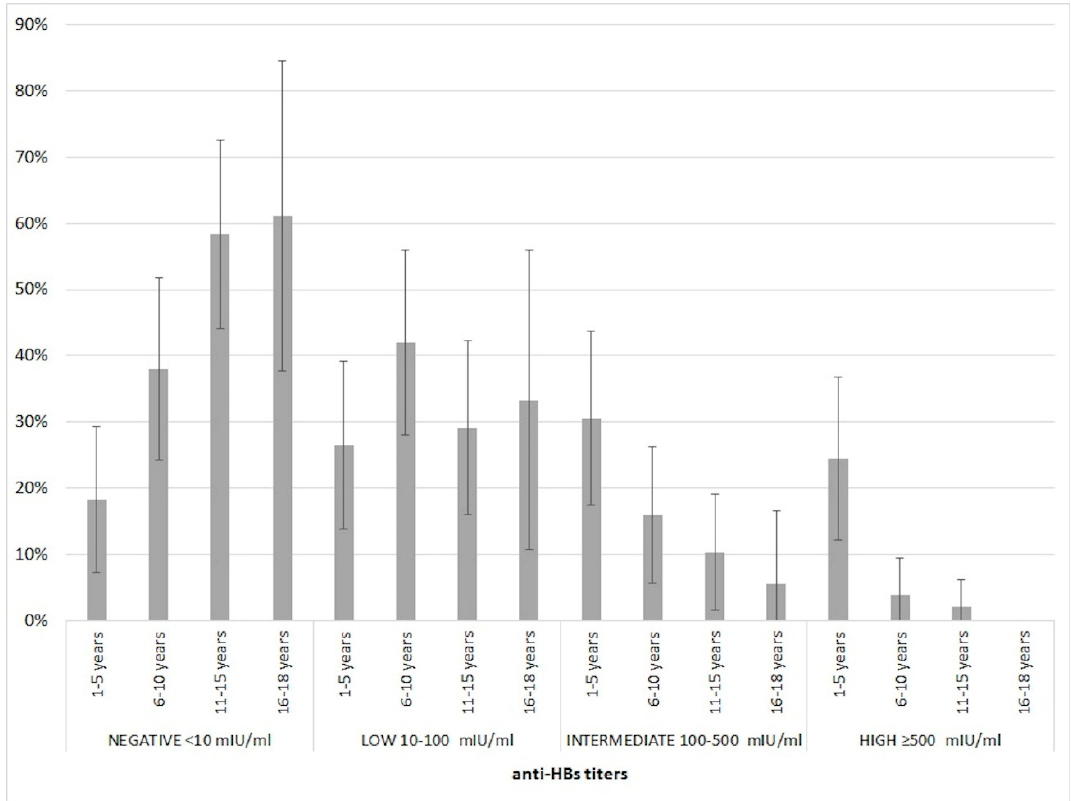
Figure 1. Percentage distribution of immunity levels in the total of subjects of different age groups.